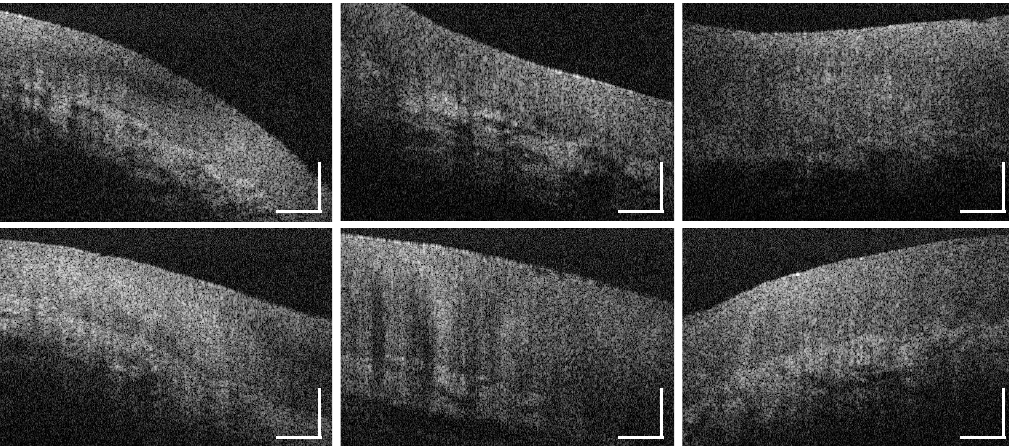
Figure A16. Supplementary intensity-based OCT cross sections of the buccal mucosa of the anterior inner cheek (MP6, Figure 1). Scale bars: 200 µ